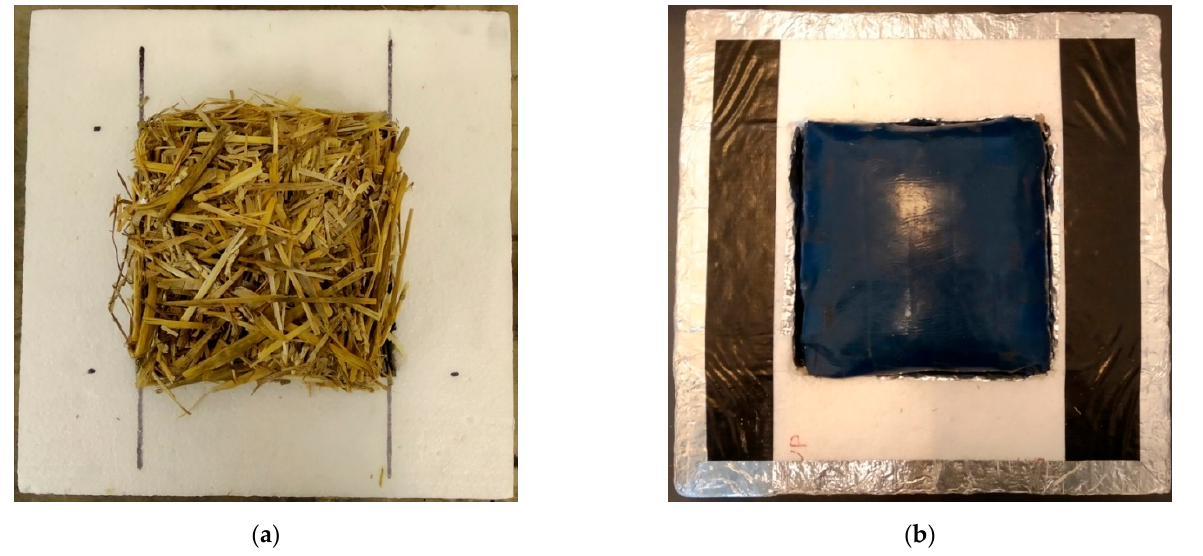
Figure 6. ( a ) Randomly oriented straw bulks; ( b ) closed measuring box filled with randomly oriented straw bulks